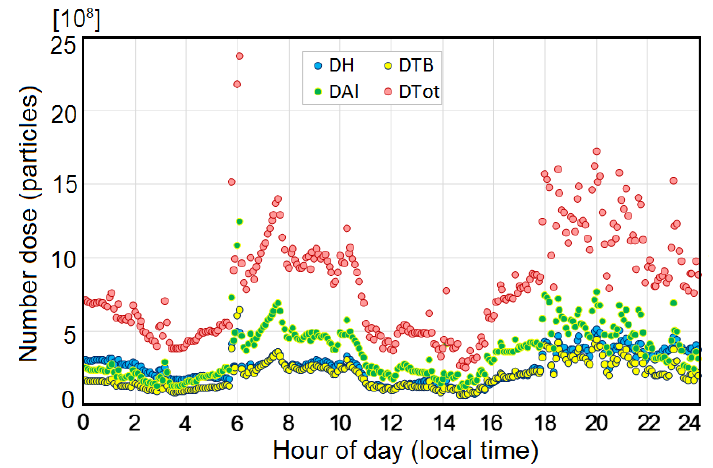
Figure 9. Aerosol number doses deposited every 5 min in the head (H), tracheobronchial (TB) , alveolar (Al) regions and total doses estimated for 20 February